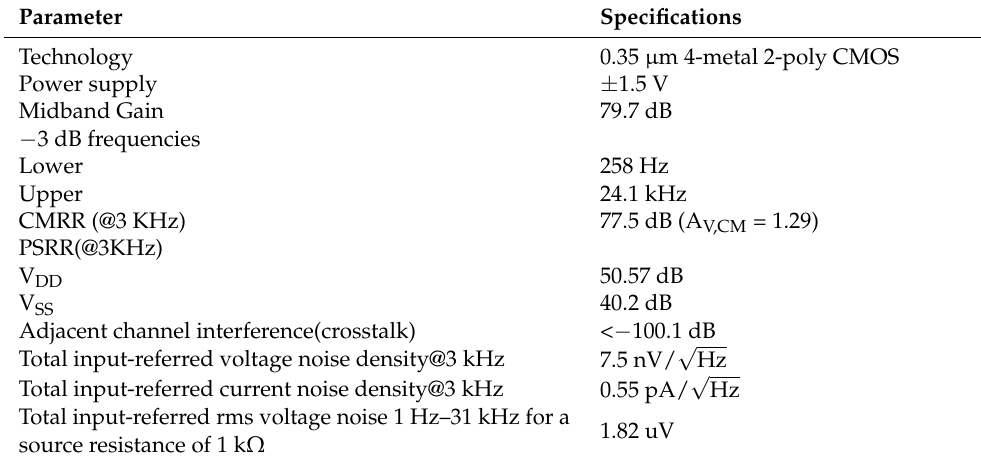
Table 7. Summary of amplifier specifications